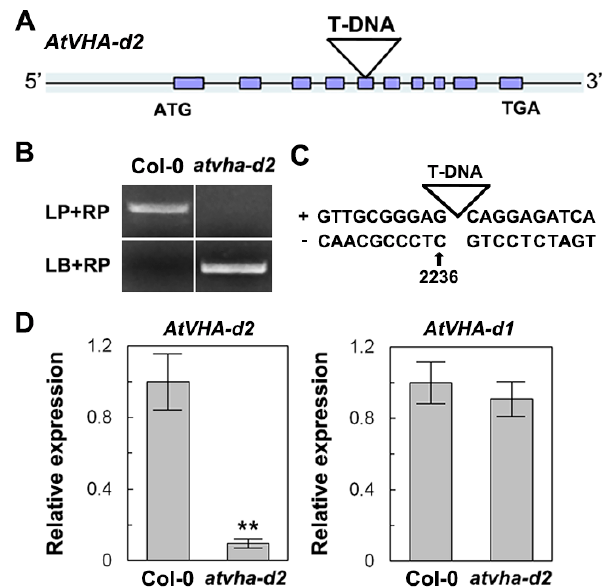
Figure 5. Identification of the Arabidopsis atvha-d2 mutant. Schematic representation of AtVHA-d2 ( A ) and genotyping (genomic DNA) ( B ). Original PCR detection pictures are shown in Figure S1. ( C ) The position of the T-DNA insertion in the atvha-d2 mutant. (D) Relative expression (mRNA) analysis of AtVHA-d2 and AtVHA-d1 in the atvha-d2 mutant by qPCR. Asterisks indicate a significant difference between Col-0 and atvha-d2 plants (** p < 0.01; Student’s t- test). Error bars represent the SD ( n = 3).